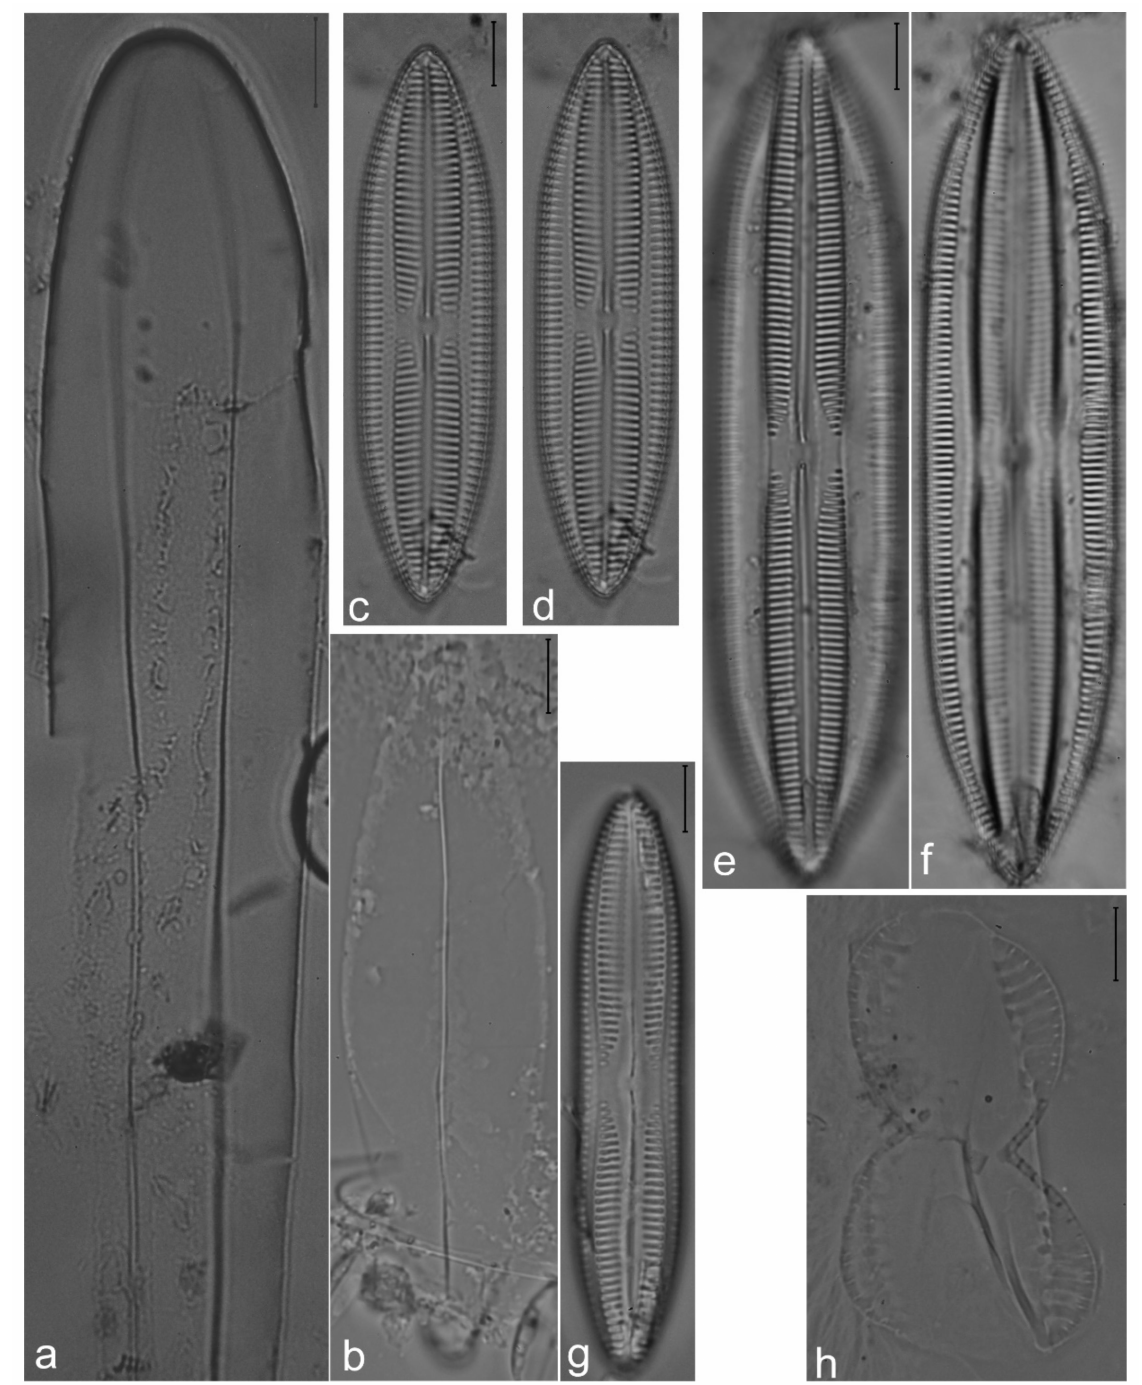
Figure 11. ( a ) Climacosphenia elongata ; ( b ) Striatella unipunctata ; ( c – f ) Oestrupia powellii ; ( g ) O . zanardiniana ; ( h ) Entomoneis paludosa . Scale bar = 10 µ